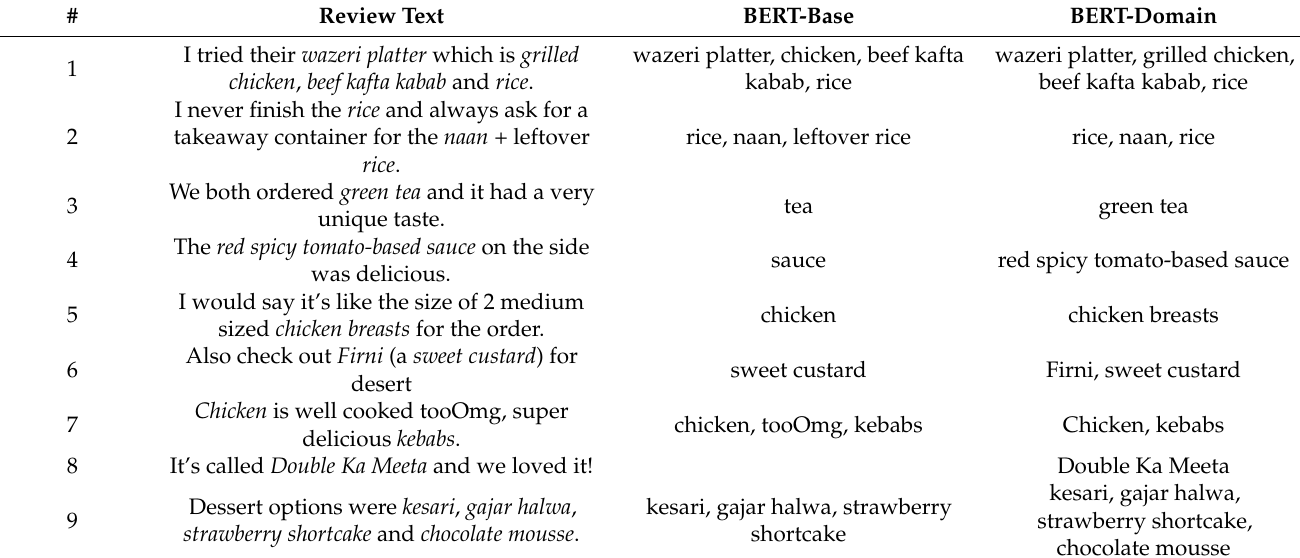
Table 4. Menu entities’ prediction from applying BERT-base features vs. BERT-domain features to the deep learning